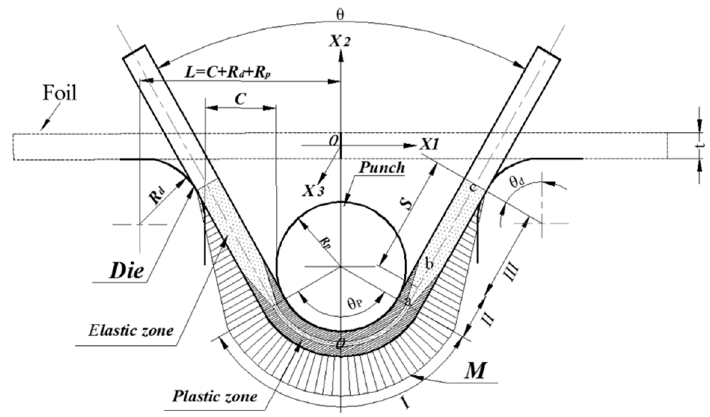
Figure 8. Schematic of the coordinate system and the bending moment distribution.